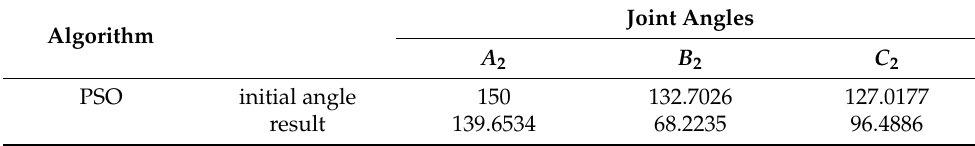
Table 16. The results obtained by the PSO for the engineering problem.